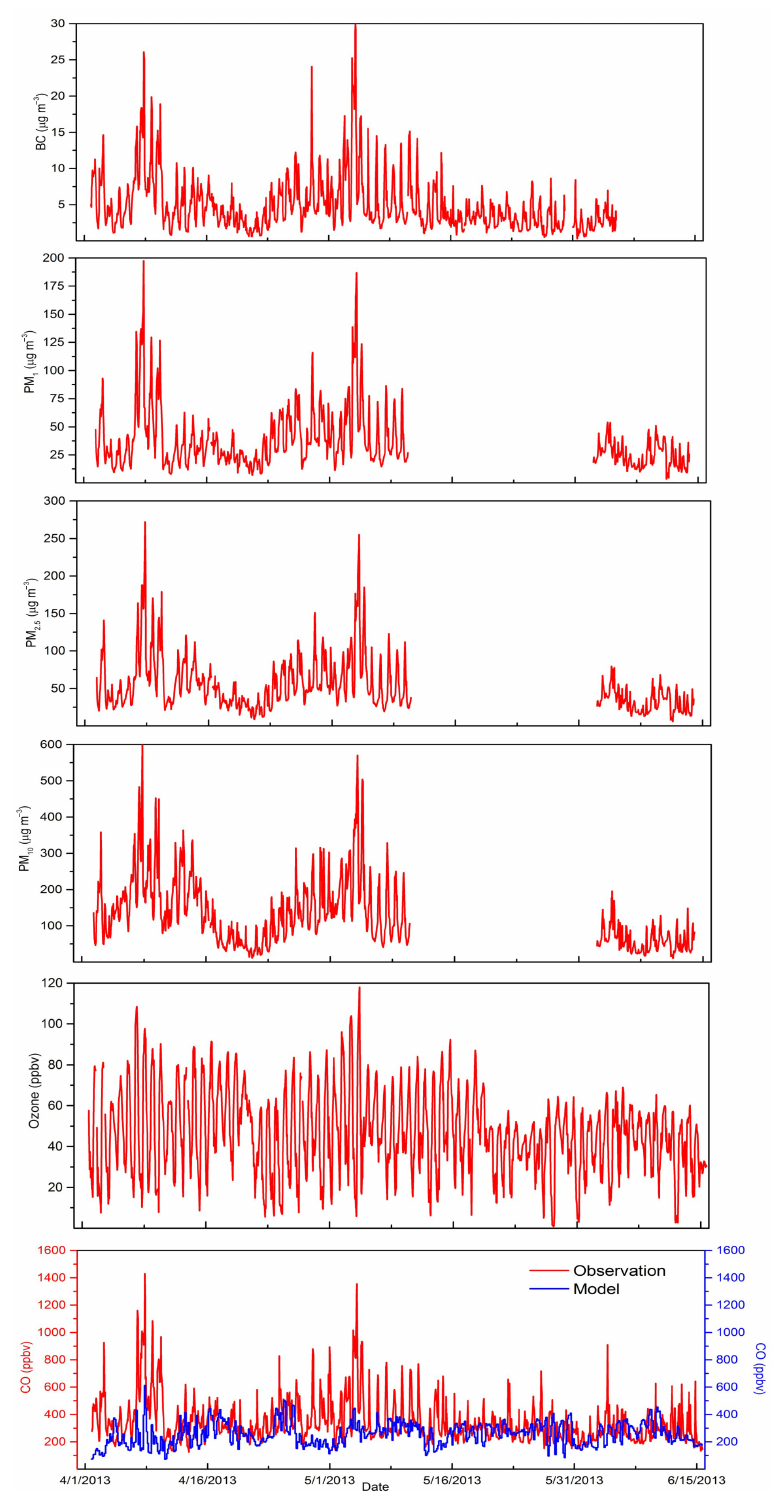
Figure 3. Time series of the observed (red line) and model estimated (blue line) hourly average concentrations of BC, PM 1 , PM 2 . 5 , PM 10 , O 3 and CO at Lumbini, Nepal, for the entire sampling period from 1 April to 15 June